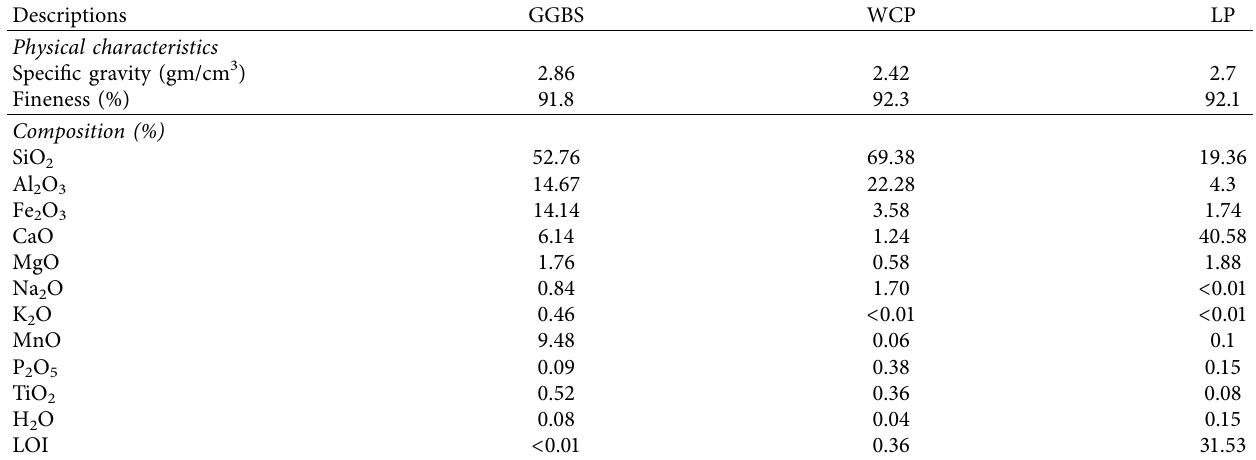
Table 1: Physical and chemical properties of GGBS, WCP, and